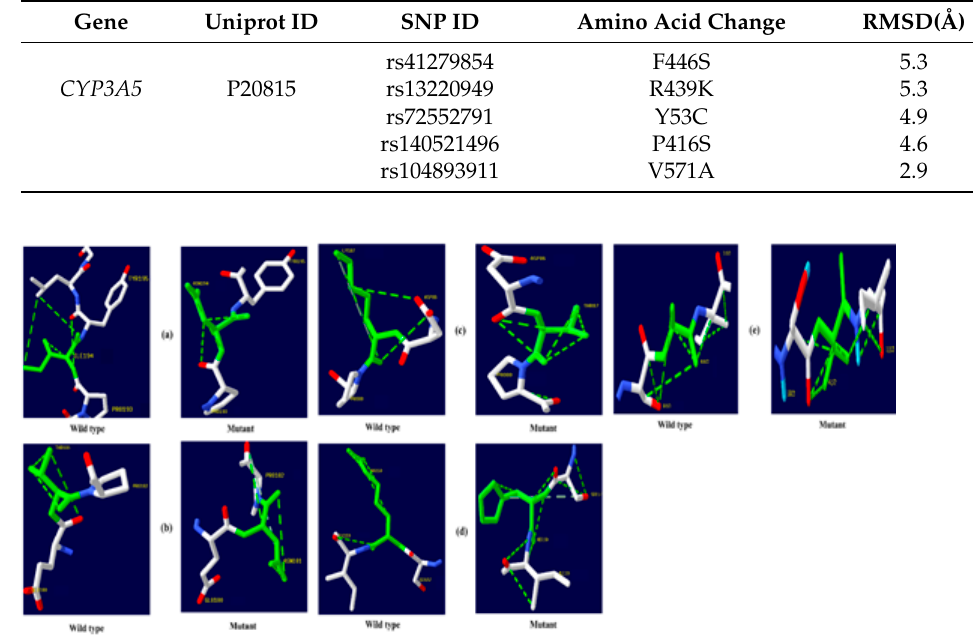
Figure 4. TNF- α hydrogen bonding results ( a ) I194N, ( b ) T181N, ( c ) K87T, ( d ) R158H, and ( e ) A172V.